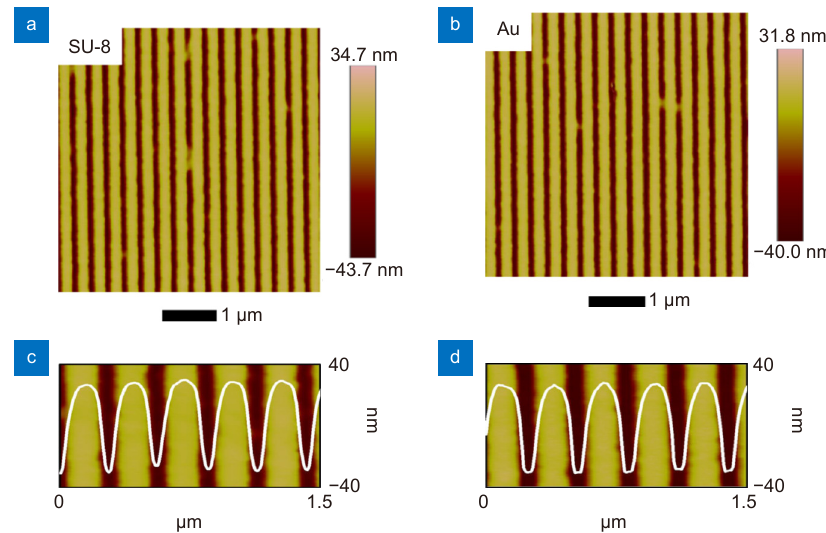
Fig. 2 | The AFM images of corrugations ( a ) prepared on glass substrate by NIL and ( b ) after deposition of ultrathin Au electrode. ( c ) and ( d ) are the height profiles of corrugations on the substrate and Au electrode, respectively. The periodic corrugations before and after deposition of Au film show consistent surface